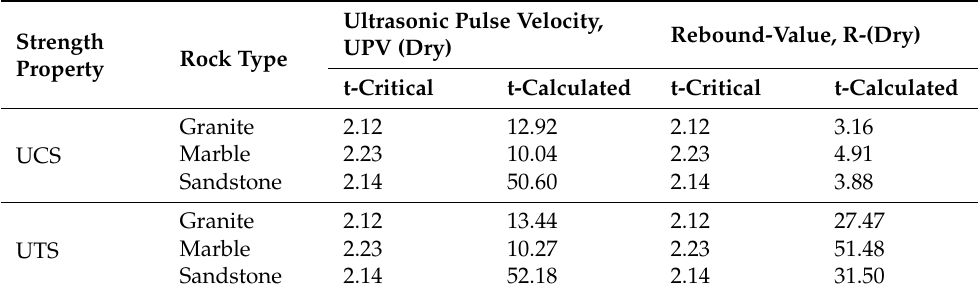
Table 10. Results of the t -test for the correlation of NDTs- dry against the strength properties of the studied